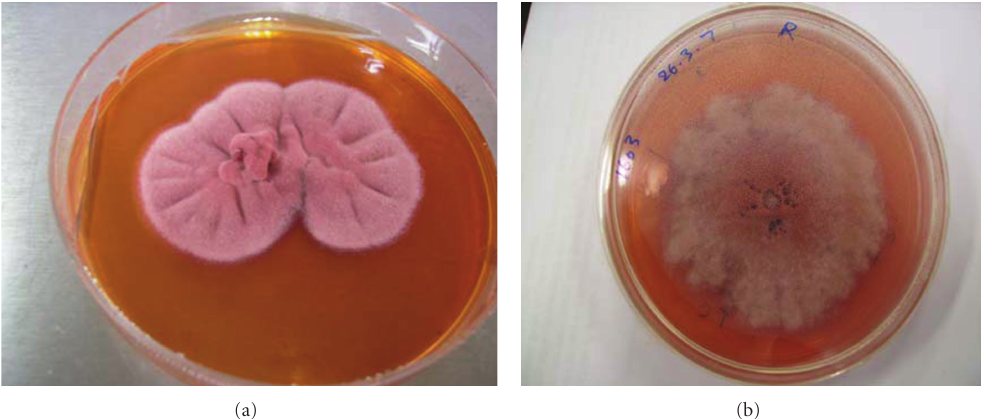
Figure 5: Di ff erent morphologies of M. purpureus DSM 1603 colonies cultivated using two di ff erent media, Hiroi-PDA (a) and PDA (b).